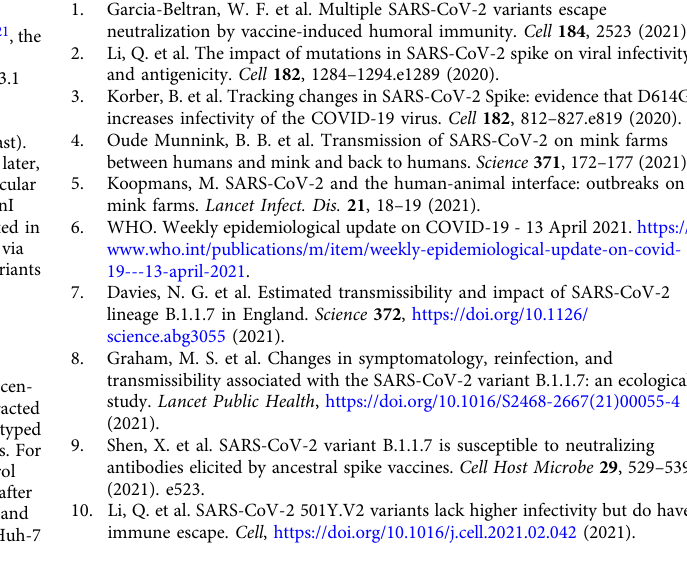
Supplementary Table 1. Pseudotyped SARS-CoV-2 variants were quanti fi ed via RT-PCR using VSV P protein as an internal control. Viruses of multiple variants were diluted to the same number of copies before use in